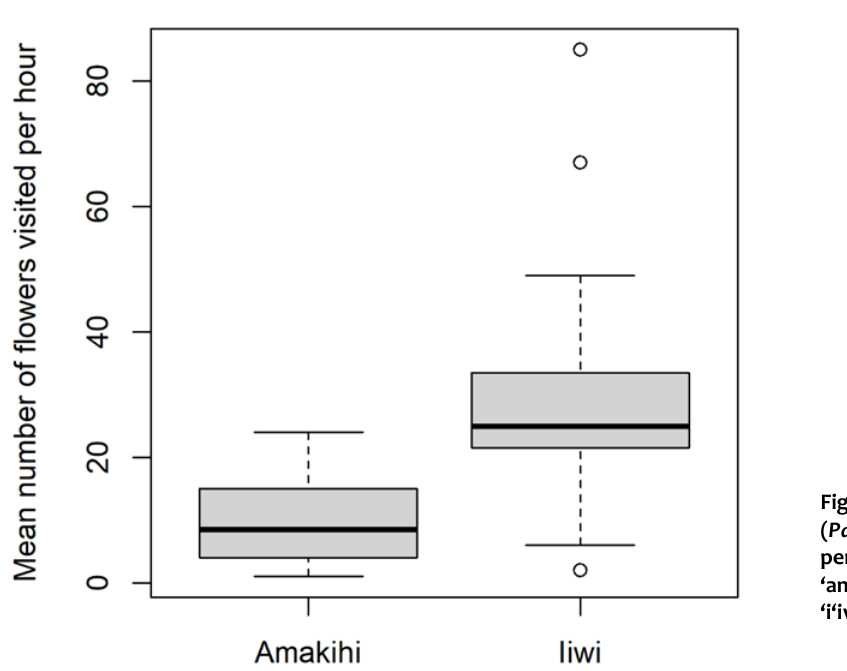
Figure 1. Mean number of banana poka ( Passiflora tarminiana ) flowers visited per observation hour by Hawai‘i ‘amakihi ( Chlorodrepanis virens ) and ‘i‘iwi ( Drepanis coccinea